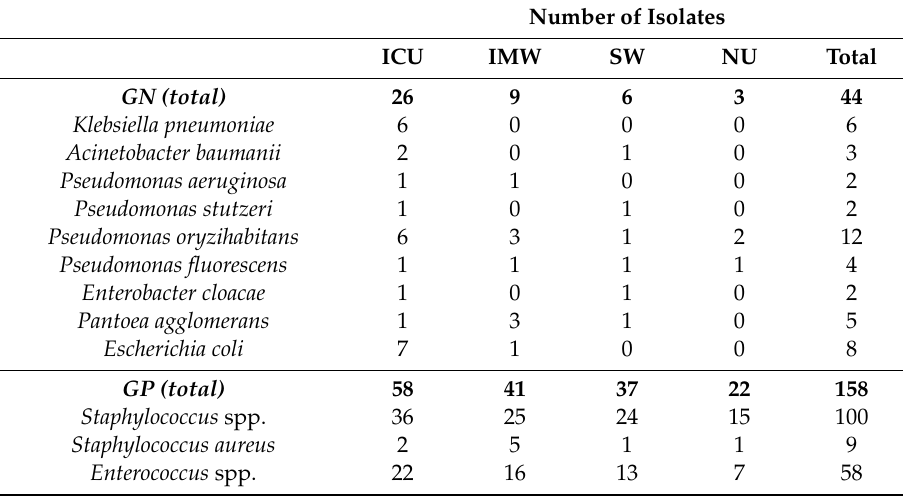
Table 2. Number of isolates in each